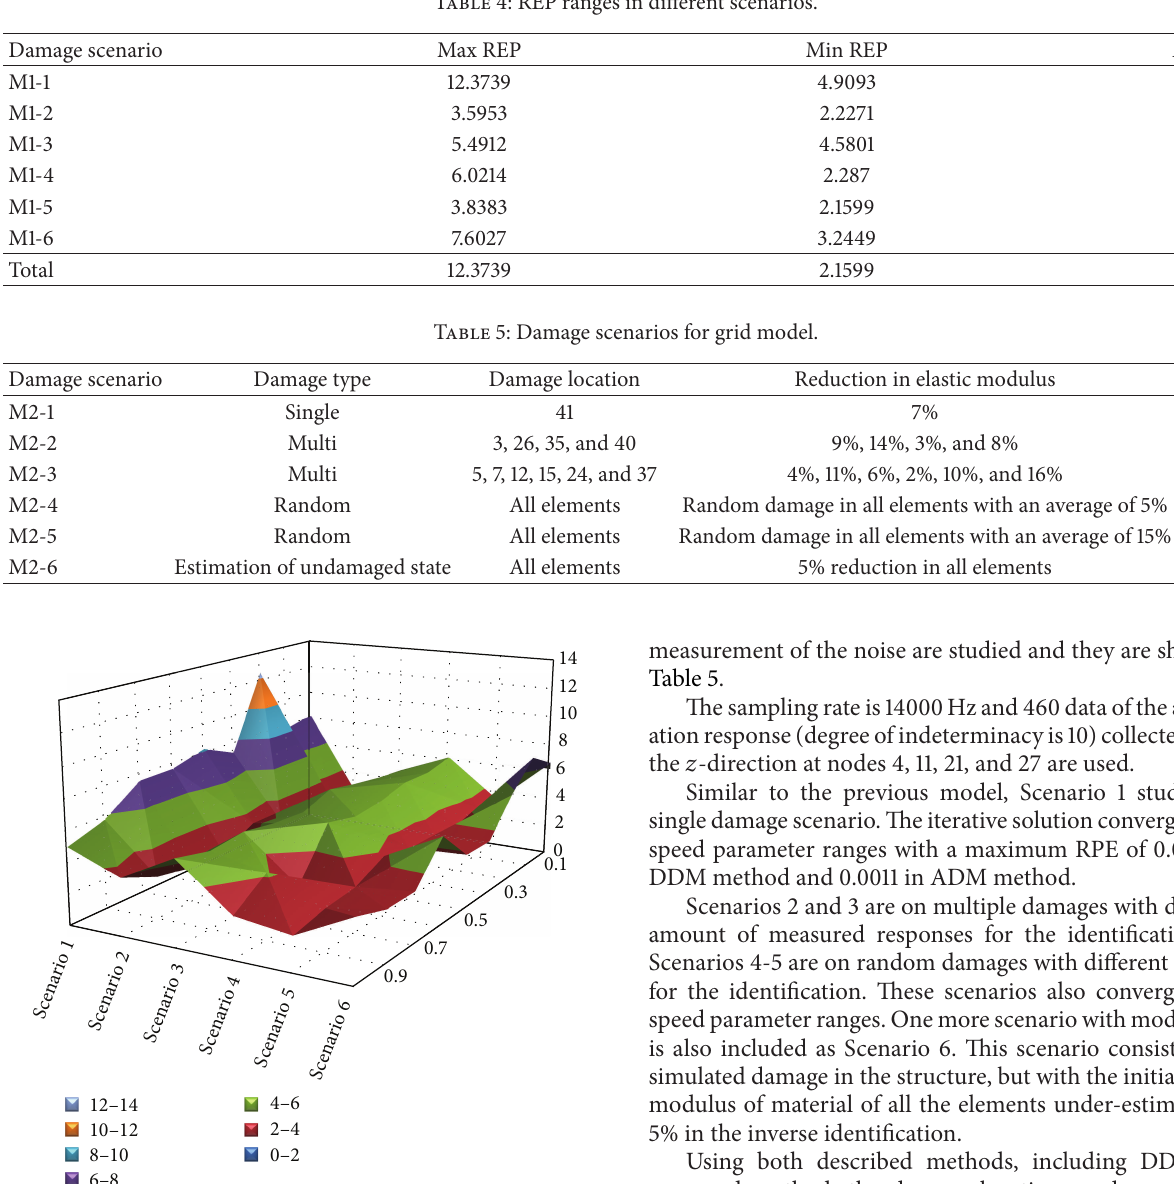
Table 4: REP ranges in different scenarios.